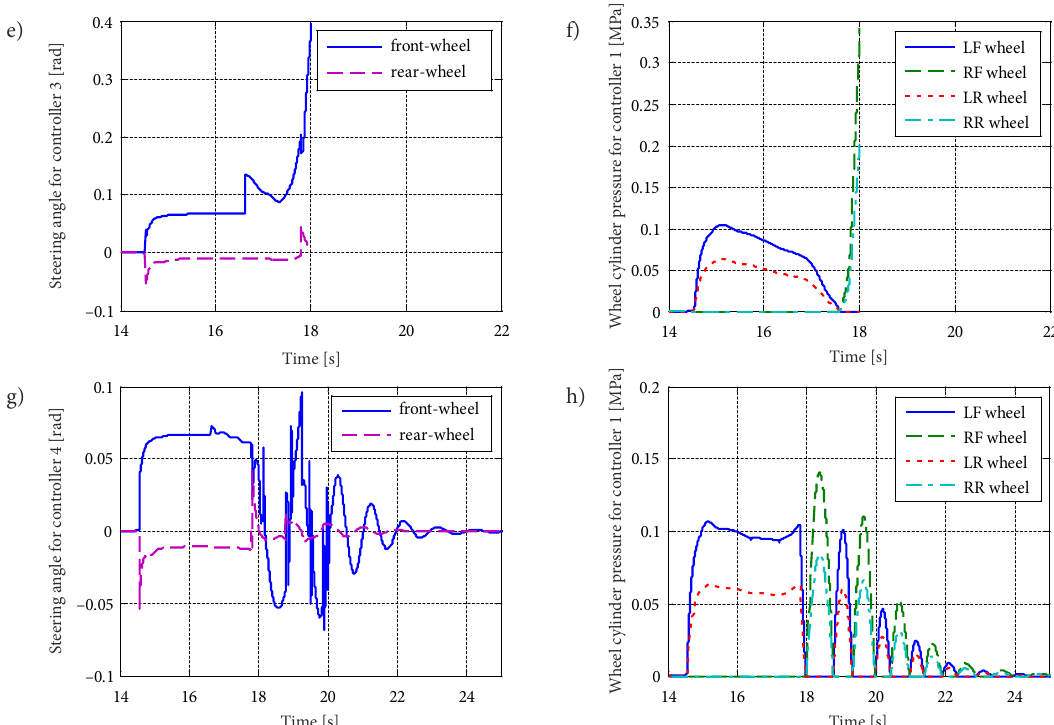
Figure 10. The steering angles and four brake cylinder pressures in the anti-rollover simulation: a, b – red vehicle; c, d – blue vehicle; e, f – green vehicle; g, h – white